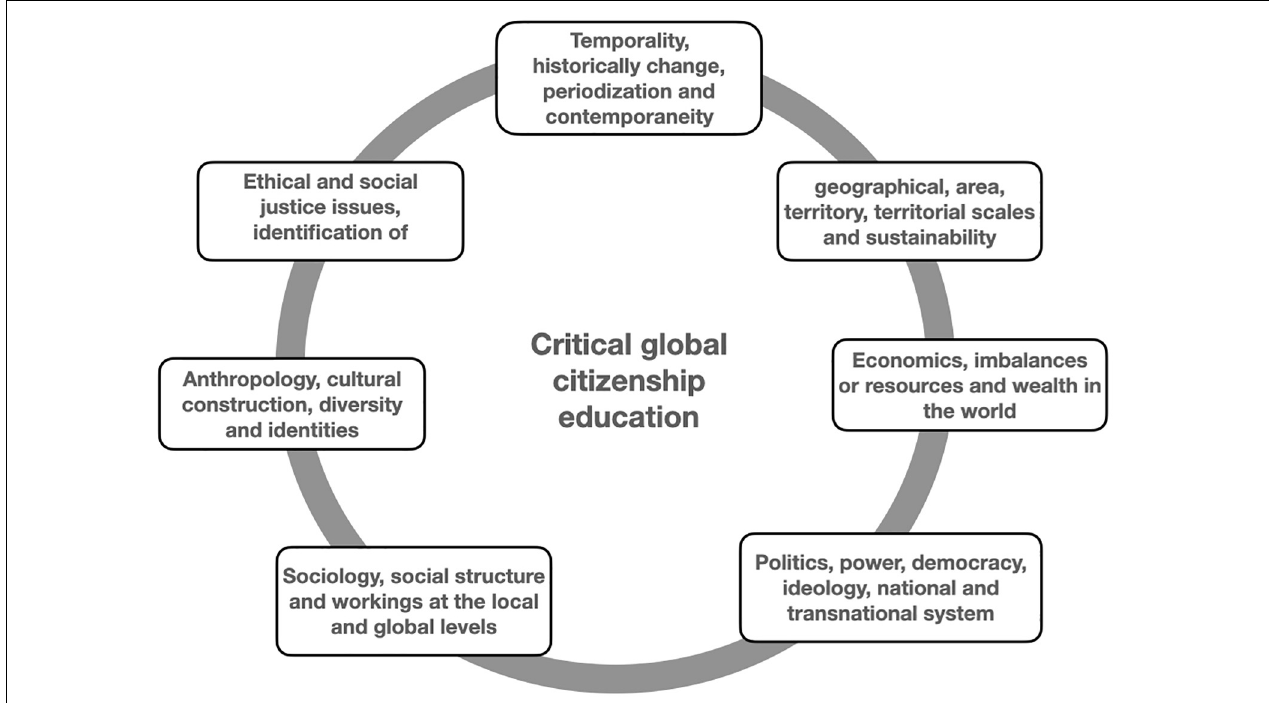
FIGURE 1 | Social sciences contribution to critical global citizenship